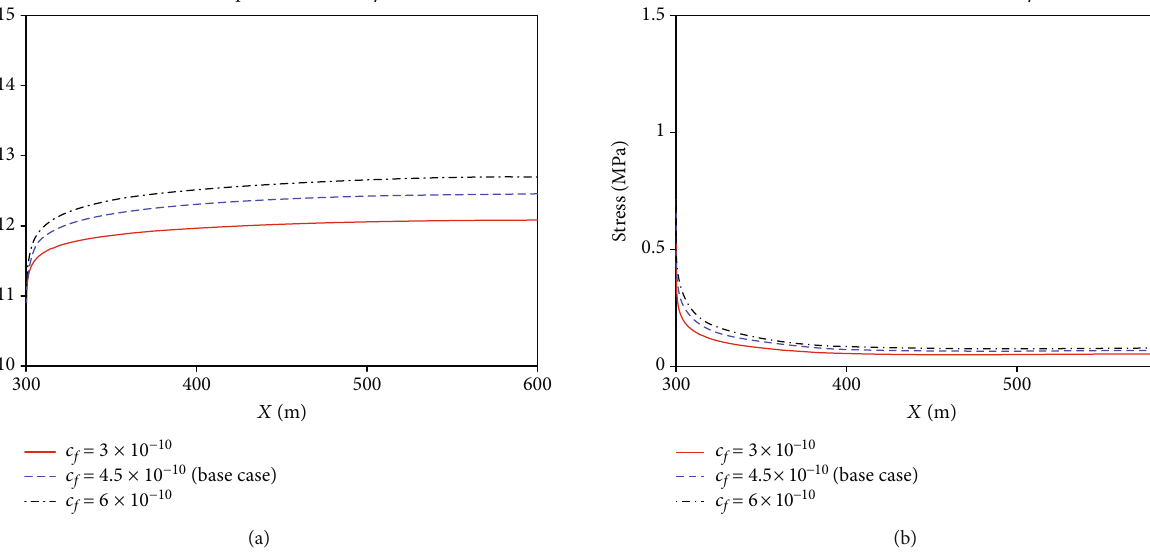
Figure 19: 1D (a) pressure and (b) stress distributions from the wellbore to the domain boundary along Y = 300m after 1 day of shallow water fl ow for water compressibility